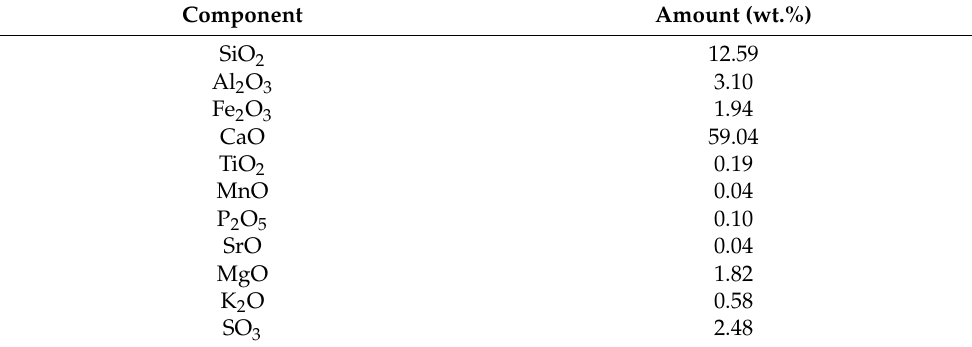
Table 1. Chemical composition of Portland II/B-L 32.5R cement (provided by the supplier).